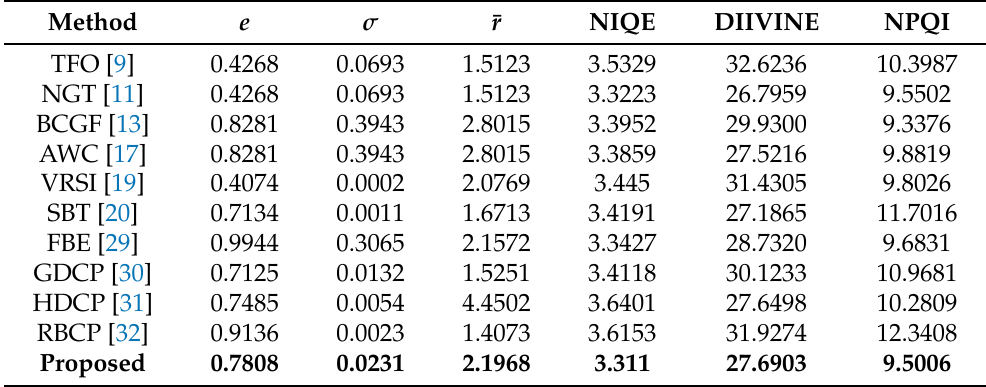
Table 1. Average results of non-reference evaluation of 12 sand dust images. Method